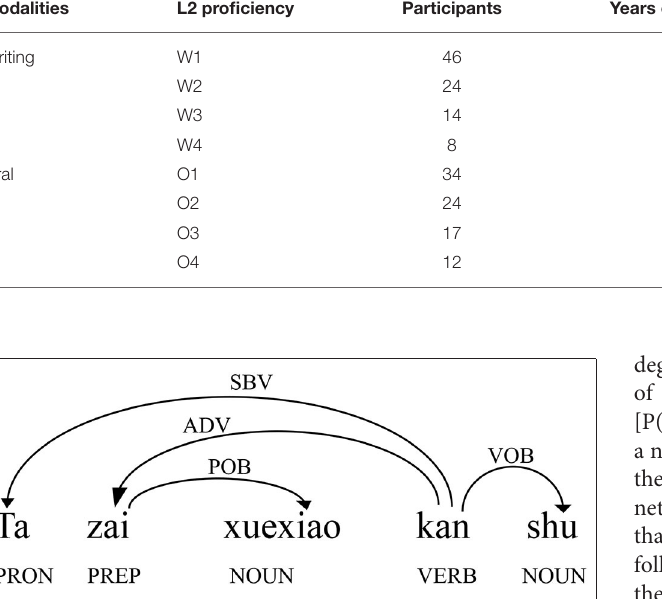
FIGURE 1 | Dependency structure of the sentence Ta zai xuexiao kan shu (“he reads books at school”). The word pointed by the arrow is the dependent.